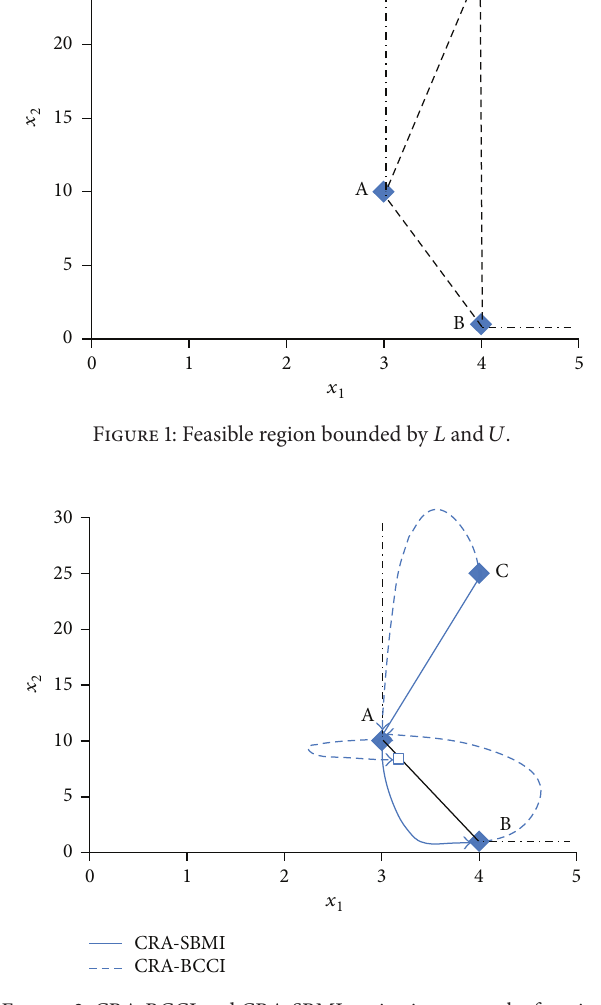
Figure 2: CRA-BCCI and CRA-SBMI projections onto the frontier